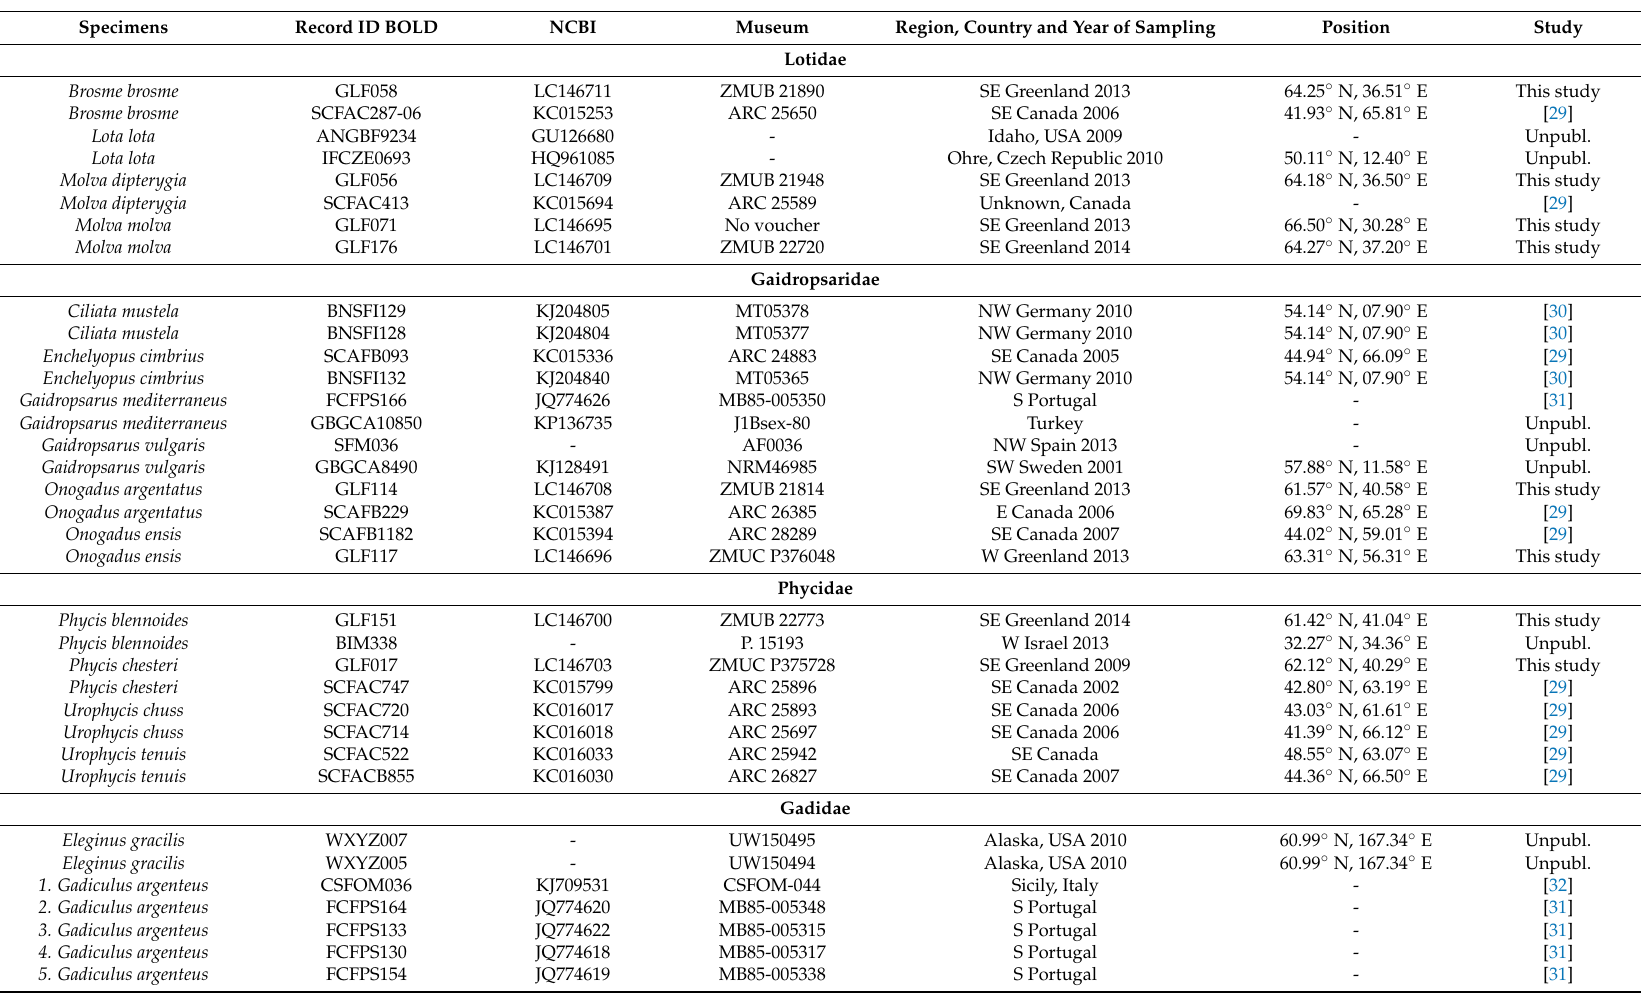
Table 2. 96 Specimens used for molecular comparisons of the Cox1 barcode in this study. Numbers for Gadiculus spp. correspond to Figure 8. The dataset is available as (DS-PGJP) from